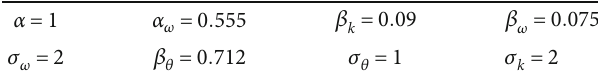
Table 1: Empirical constants